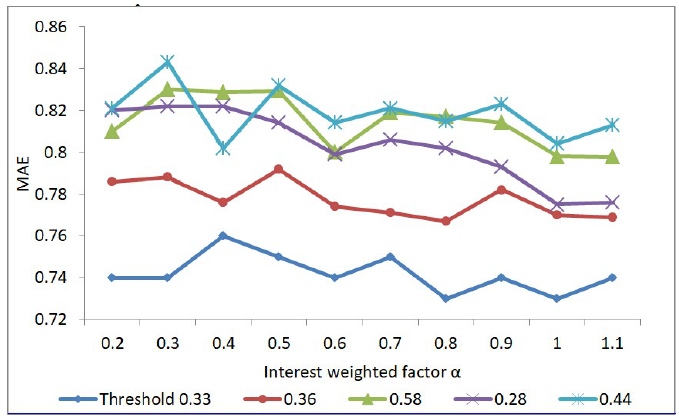
Figure 9. MAE with threshold and interest weighted factor.